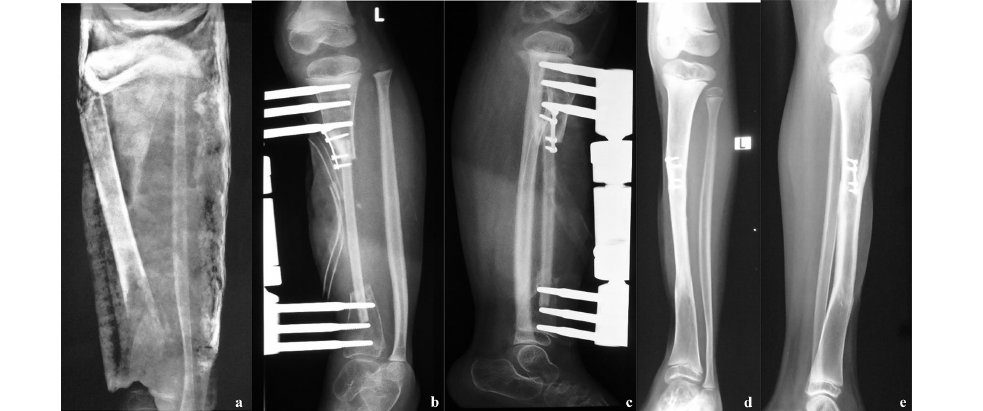
Figure 6. (a) Radiographs taken at presentation of a 5-year-old girl with an extruding sequestrum of the left tibia, with soft tissue loss; (b, c) post-VFF radiographs; (d, e) radiographs taken 3 years postoperatively. There is sound bone reconstruction, with perfect integration of the VFF, hypertrophy and